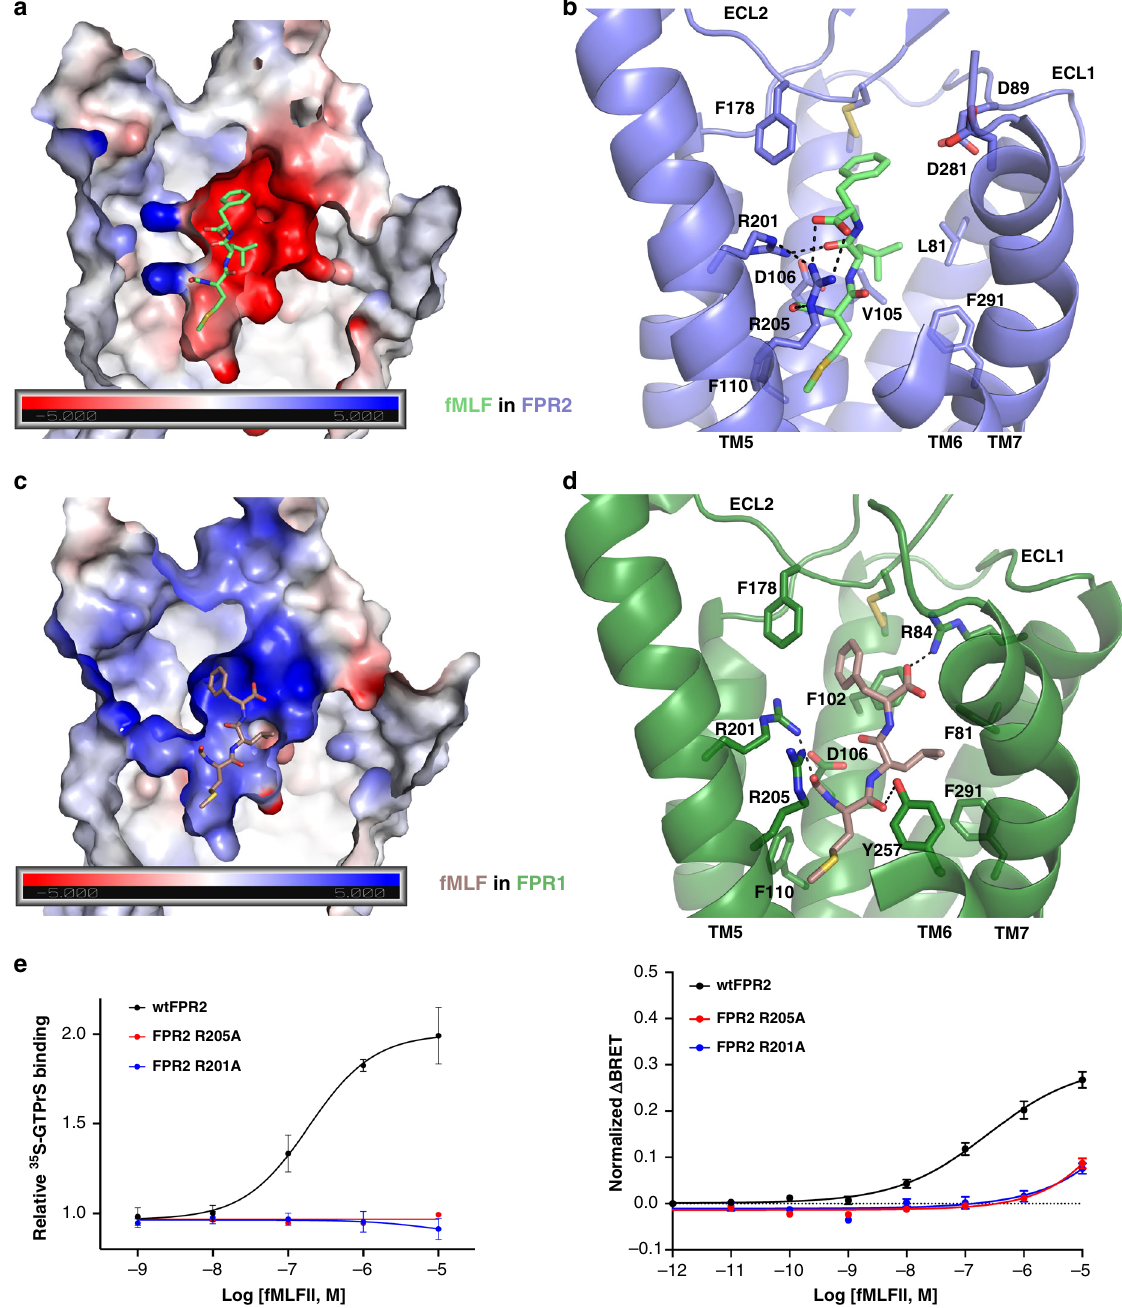
Fig. 4 Peptide-binding pockets in FPR1 and FPR2. a Negatively charged environment of the ligand-binding pocket in FPR2 and docked fMLF peptide. b Molecular details of the ligand-binding pocket in FPR2 for fMLF. c Positively charged environment of the ligand-binding pocket in FPR1 and docked fMLF peptide. d Molecular details of the ligand-binding pocket in FPR1 for fMLF. Hydrogen-bonding interactions are shown as dashed lines. e Effects of mutations R205A and R201A on fMLFII-induced receptor activation determined by 35 S-GTP γ S binding assays (left) and BRET-based assays (right). BRET-based assays measured G i coupling to receptors. n = 3 – 10, data are mean ± s.e.m. Source data are provided as a Source Data fi